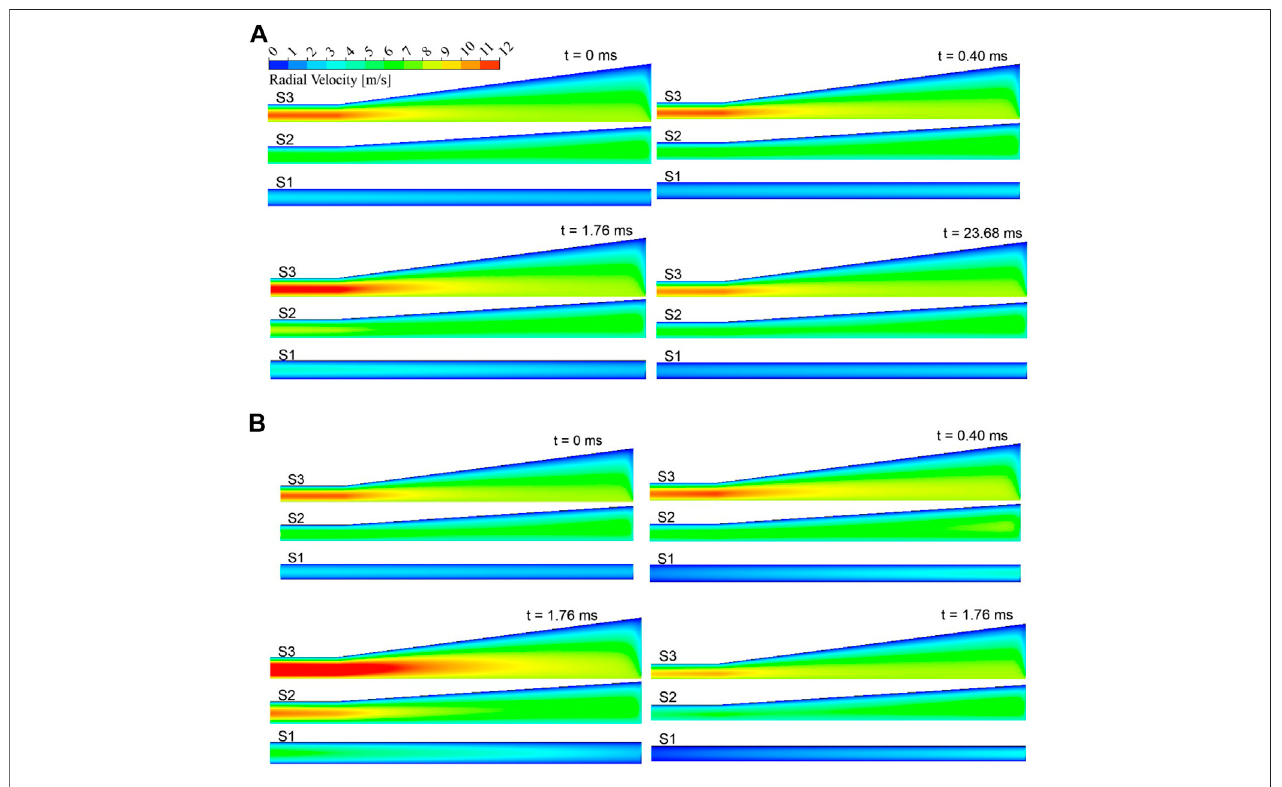
FIGURE 15 | Radial velocity distribution varies with time (A) a = 4% and (B) a = 10%.